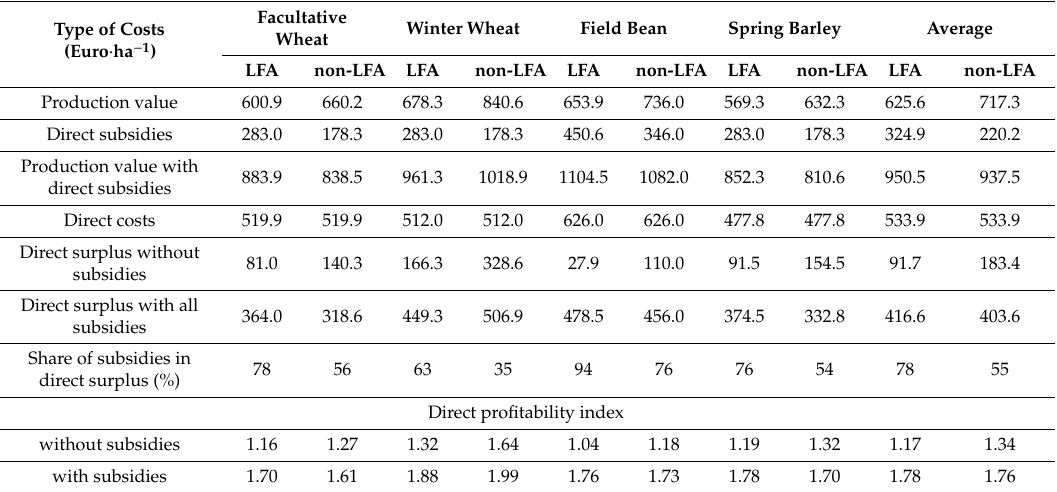
Table 4. Economic e ffi ciency indicators for crop production in the mountain LFA area and non-LFA area. Type of Costs (Euro · ha − 1